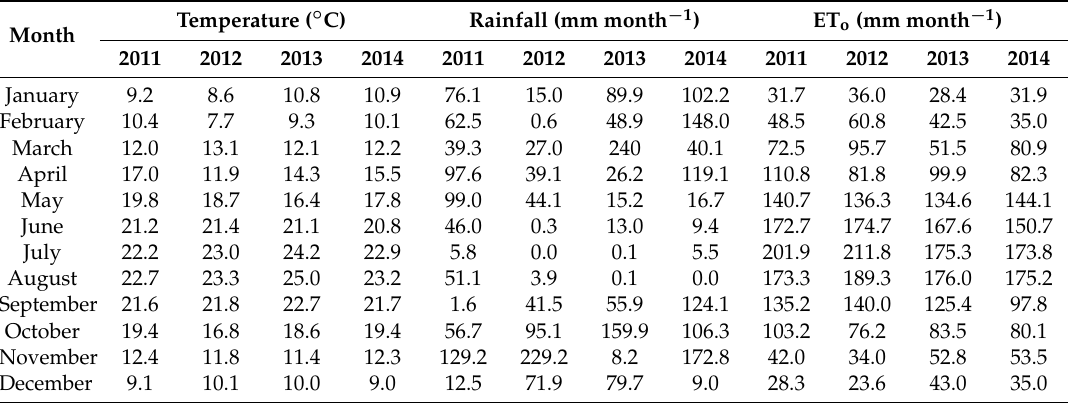
Table 1. Monthly average values of temperature ( ◦ C), rainfall (mm month − 1 ), and ET o (mm month − 1 ) in the four years of the